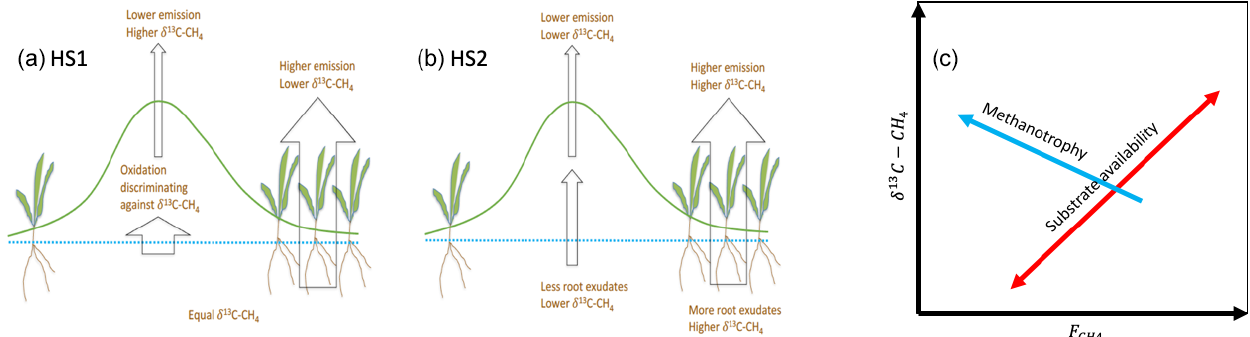
Figure 1. Spatial variation in methane emission based on two hypotheses: (a) HS1, variation is due to methanotrophy, and (b) HS2, variation is due to methanogenesis and the substrate status. Resulting relations between δ 13 C-CH 4 and F CH